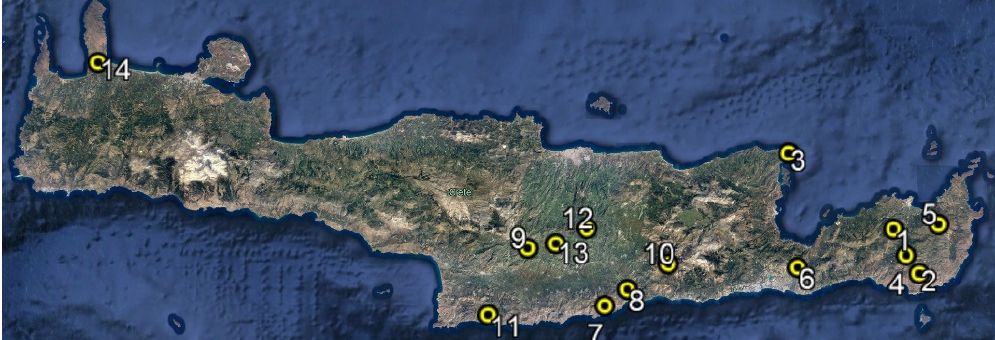
Figure 23. Location of wind potential measurements sites on Crete.